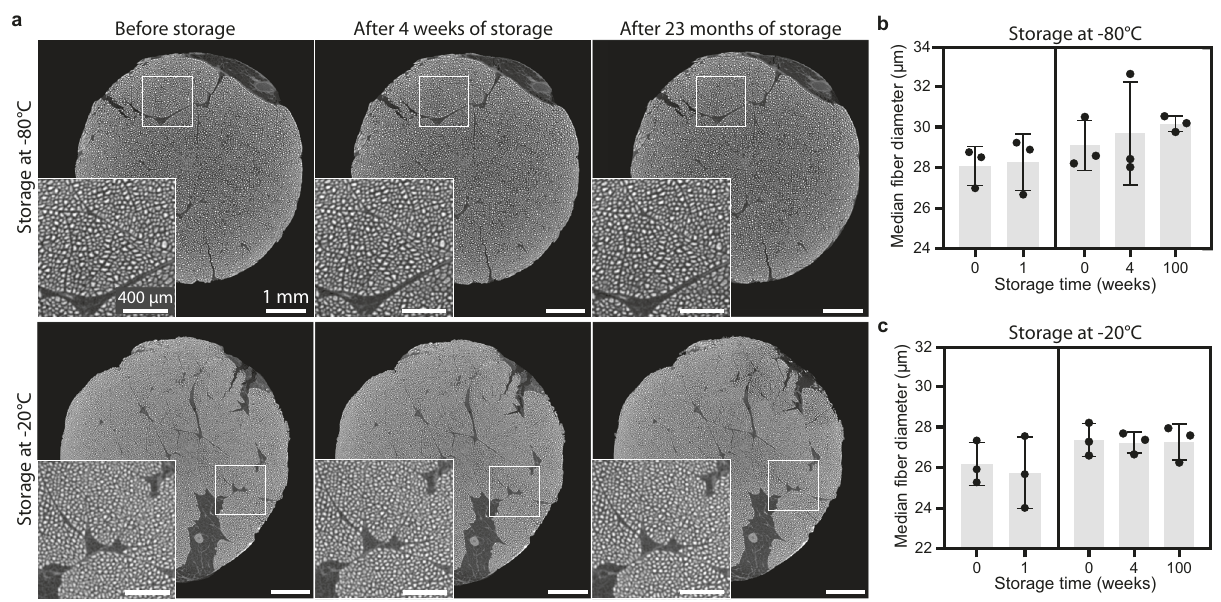
Fig. 4 | Stability of the fast-frozen microstructure during low-temperature storage.a Cryo-CECTimagesoftheHf-WDPOM-stainedmuscletissueimmediately after fast freezing in isopentane at − 78°C and after storage for 4 weeks and for 23 months, at − 80°C (top) and − 20°C (bottom). Within each cryo-CECT image, a magni fi cation (white square) is shown in the inset. Pair-wise comparison of the median fi berdiameterafter1week(left)or4weeksand100weeks(right)ofstorage